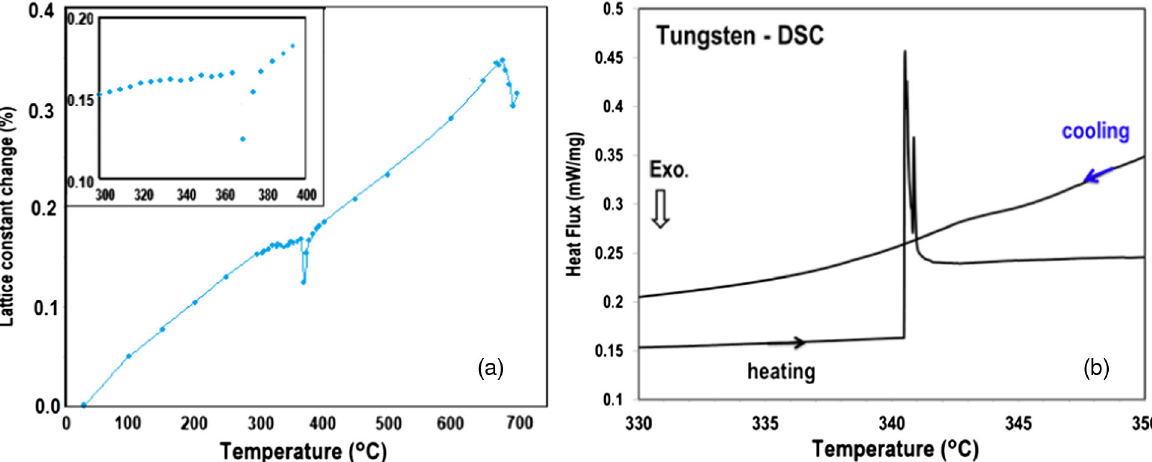
FIG. 25. Temperature dependence of the lattice parameter of unirradiated tungsten (left) and DSC analysis (right) verification of the presence of a “ transition ” in the vicinity of ∼ 340